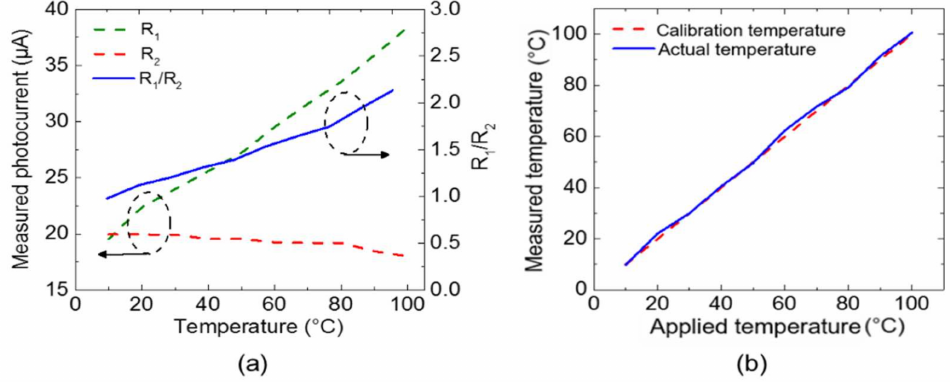
Figure 8. ( a ) Measured photocurrents and R 1 /R 2 as a function of temperature and ( b ) R 1 /R 2 dependent temperature data and calibration